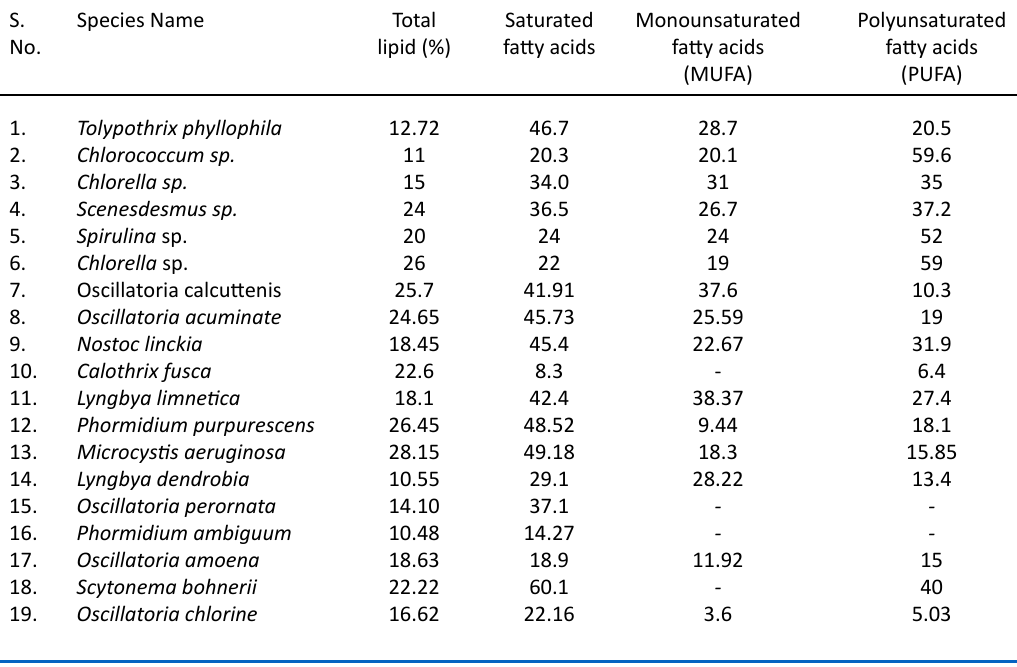
Table 3. Total lipid percentage, percentage of saturated fatty acids, MUFA and PUFA in algal and blue-green algal strains